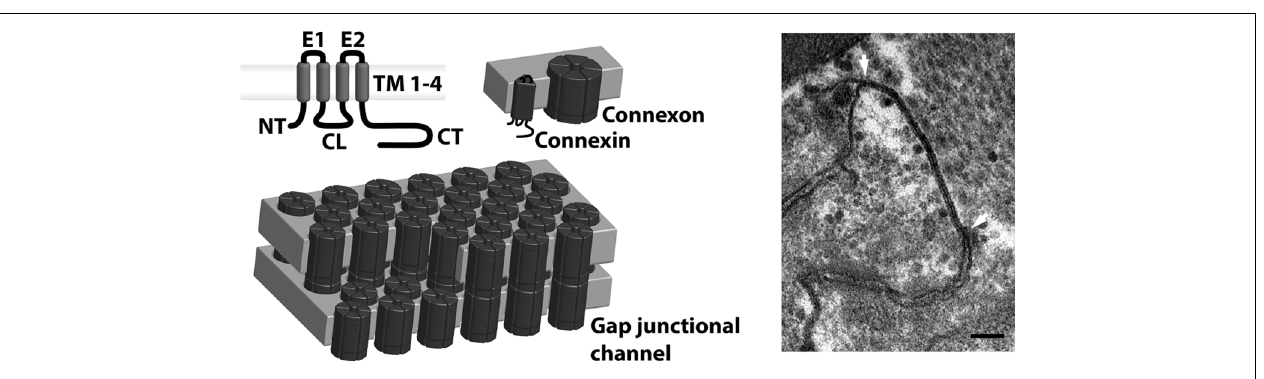
that upon opening mediate exchange of ions and small metabolites. When many channels aggregate, they form a gap junctional plaque, which can be seen as a pentalaminar structure in the transmission electron microscope. A plaque between two rat ventricular myocytes can be seen between the arrows in the right panel of the figure (scale bar 100 nm). The image was obtained in collaboration with Klaus Qvortrup, Core Facility for Integrated Microscopy, University of